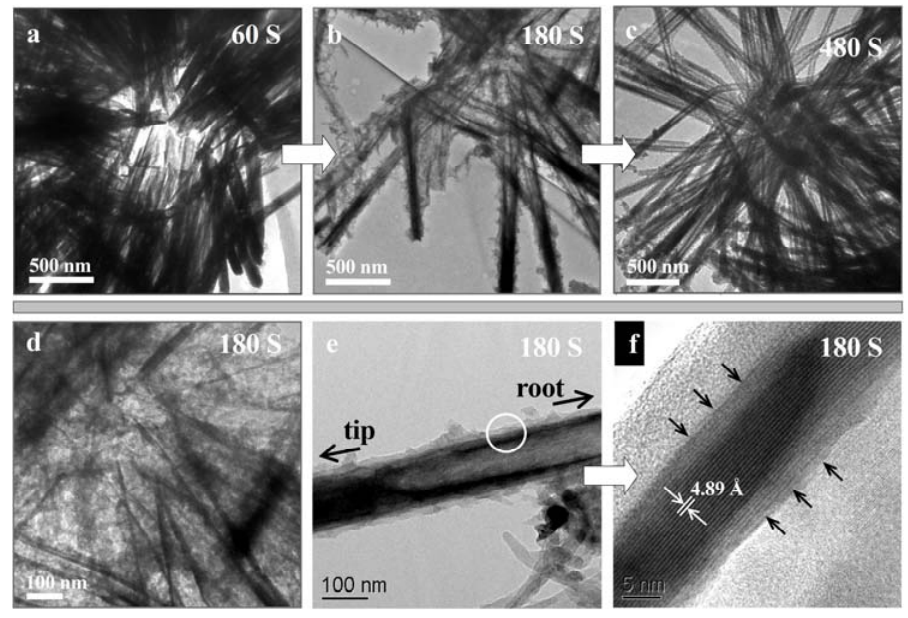
Figure 7. Transmission electron microscopy (TEM) images show the structural evolution during the conversion from cryptomelane phase manganese nanowires to polyaniline nanotubes after: a ) 60 s; b ) 180 s; and c ) 480 s. d ) the magnified image of the root region of (b). e ), f ) HRTEM (high-resolution TEM) images indicate the formation of polyaniline (shell)/manganese oxide (core) composite tube in the corrosive etching of manganese oxide. The scale bar is 1 µm. Reproduced with permission from Wiley-VCH Verlag [27].